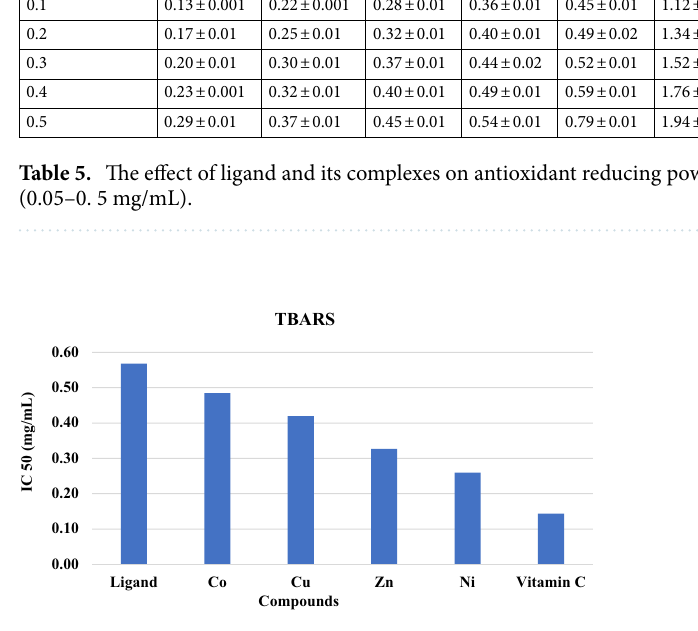
Figure 9. TBARS IC50 values for vitamin C, its ligand, and its metal complexes.